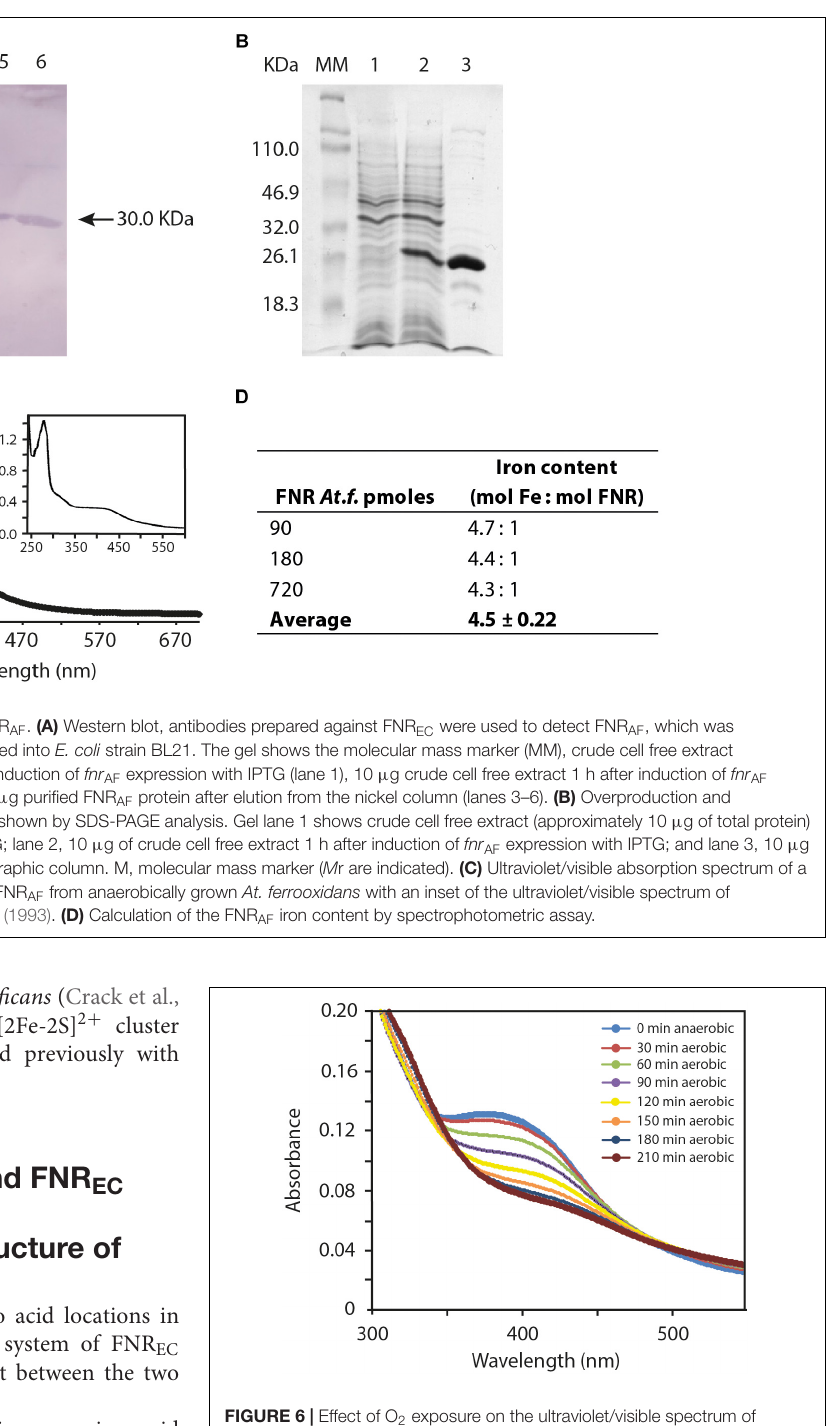
The primary amino acid sequences were then compared to three dimensional models of FNR AF and FNR EC built using the crystal structure of FNR from A. fisheri (FNR AFi ) as